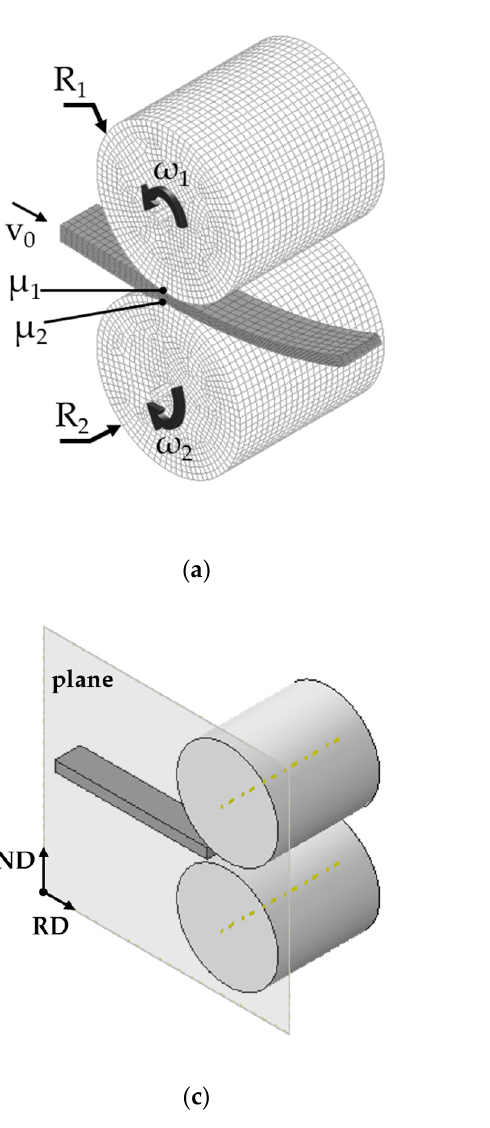
Figure 2. Boundary conditions imposed to accomplish ASR results. ( a ) A schematic of velocities and friction BC; ( b ) An illustration of the additional BC to avoid bending; ( c ) Symmetry plane RD–ND; ( d ) Geometrical model without considering symmetry in the RD–ND plane.